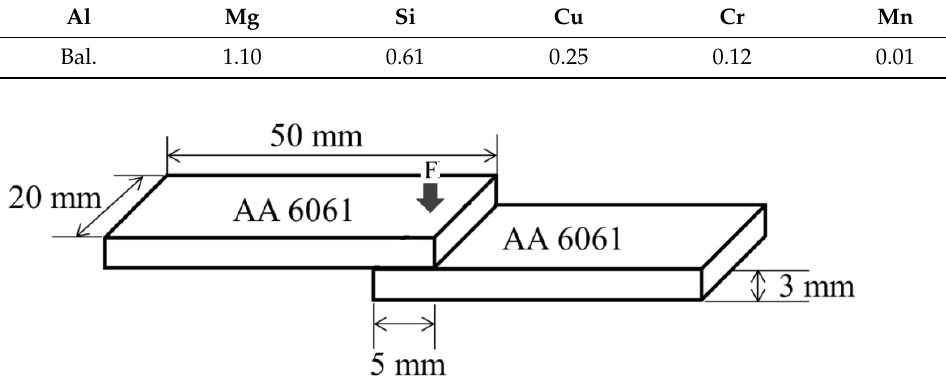
Figure 1. Schematic diagram of the geometry and dimensions of the diffusion bonded specimens subjected to SLS tests. Table 1. Chemical composition of AA 6061 aluminum alloy (wt.%).